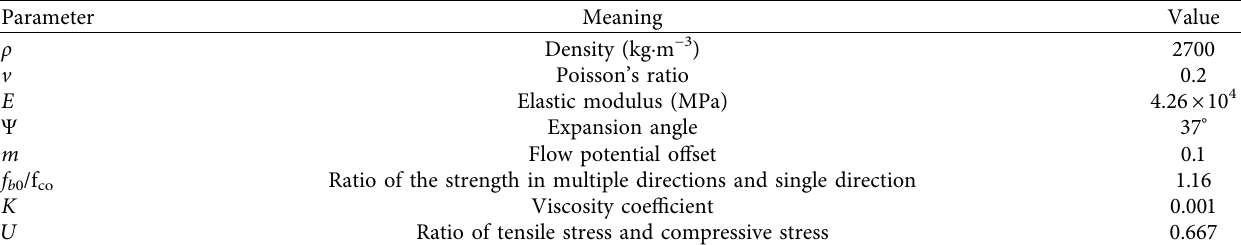
Figure 10: 3-D finite element model in ABAQUS software. (a) Corrugated steel plate. (b) UHPC layer. (c)Steel-bar mesh. (d) 3-D finite element model. Table 6: The plasticity parameters of the UHPC.